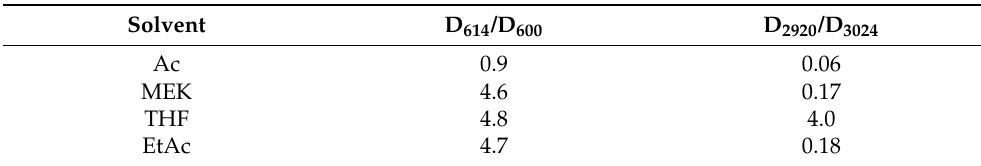
Table 4. Intensity ratios of the characteristic bands in IR transmission spectra for copolymer films crystallized from different